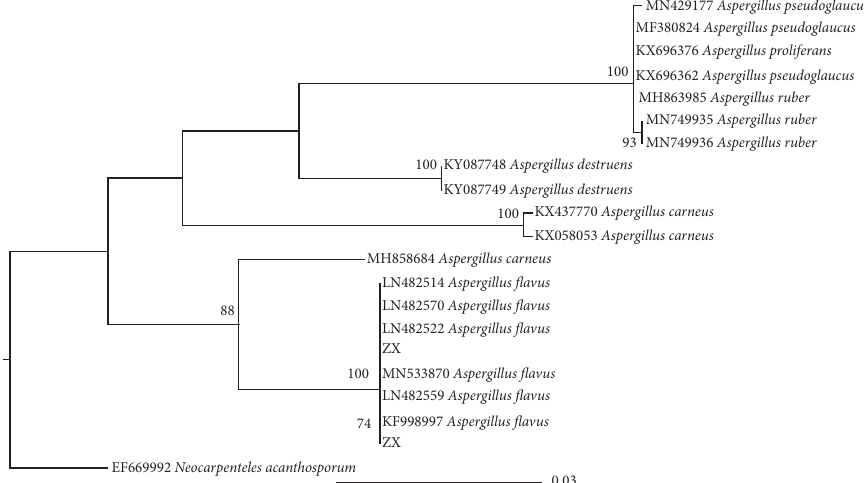
Figure 5: Phylogenetic tree shows the origin of two strains (ZK and ZX) of the fungus.